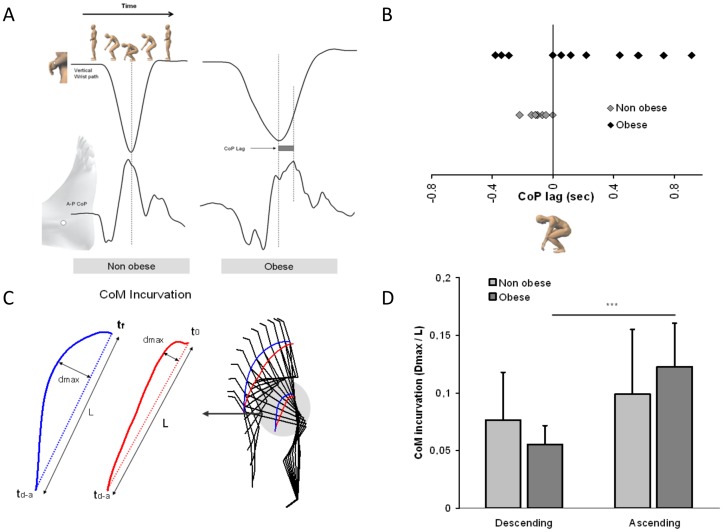
Spatio-temporal synchronization of the focal and postural components of the movement during the transition between the descending and ascending movements.The time lag between the end of the descending movement (i.e vertical wrist pathway) and the forward CoP peak (a). This difference was quantified and the average score for each individual of the two groups is shown in (b). The curvature profile of the CoM trajectory was calculated for the descending and ascending movements by the dmax/L ratio (c). Results for the two groups and the two movement directions are shown in (d).